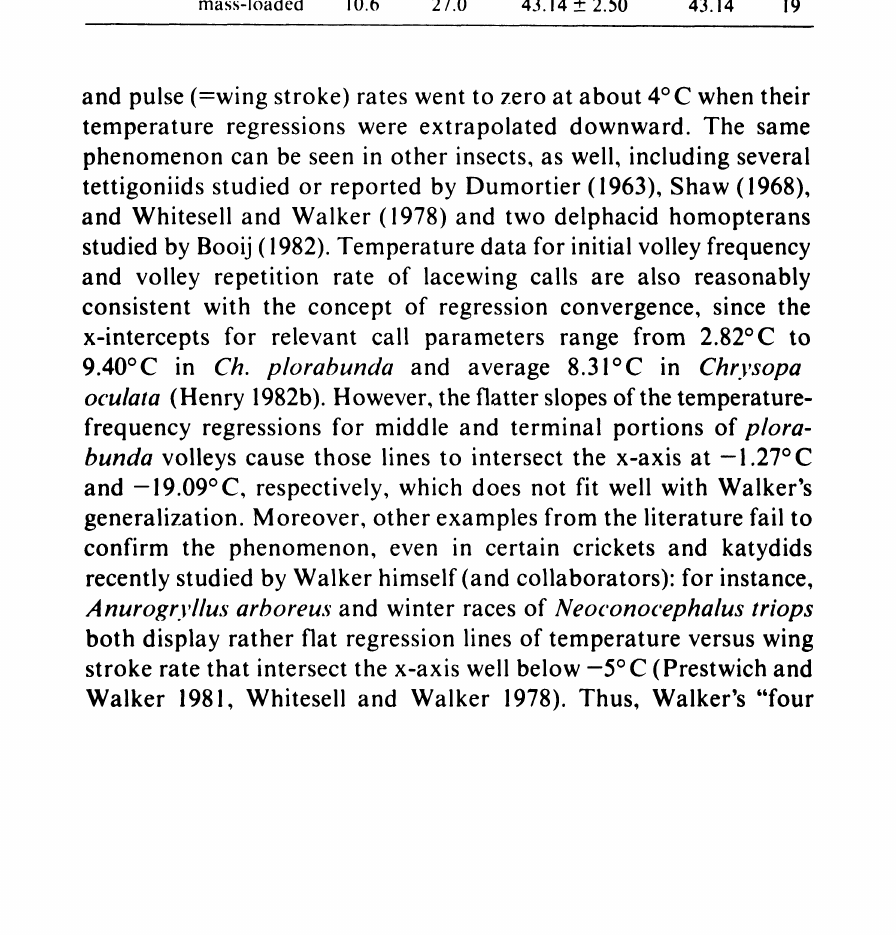
Table 2. Effect on terminal volley frequency (C), in abdominal strokes/sec, of artificially mass-loading the abdomen of three males and one female of Ch. plora- hunda. Weight gains are tabulated in column 3: the last column lists n, the number of volleys measured. Equivalent frequencies (at 27C) in column six were calculated from the slope of regression line C in Fig. 3. Superscript "x" denotes lab-reared